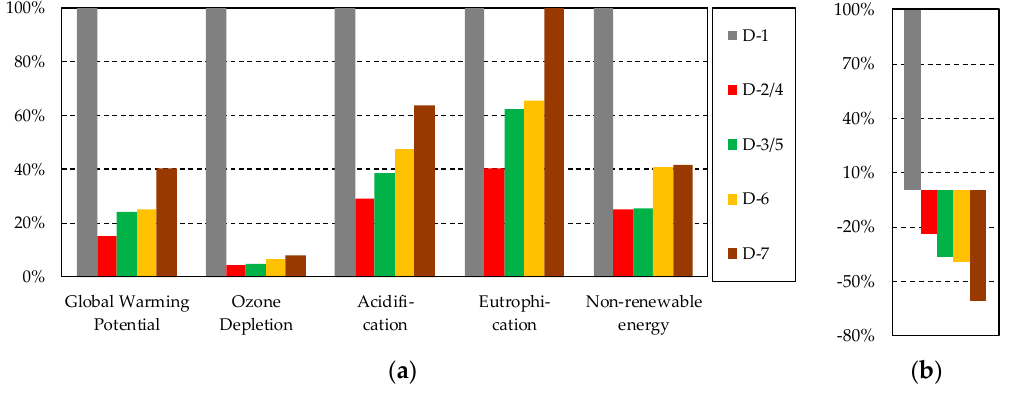
Figure 9. LCA: ( a ) ‘Cradle-to-Gate’ impact categories and ( b ) total global warming potential.